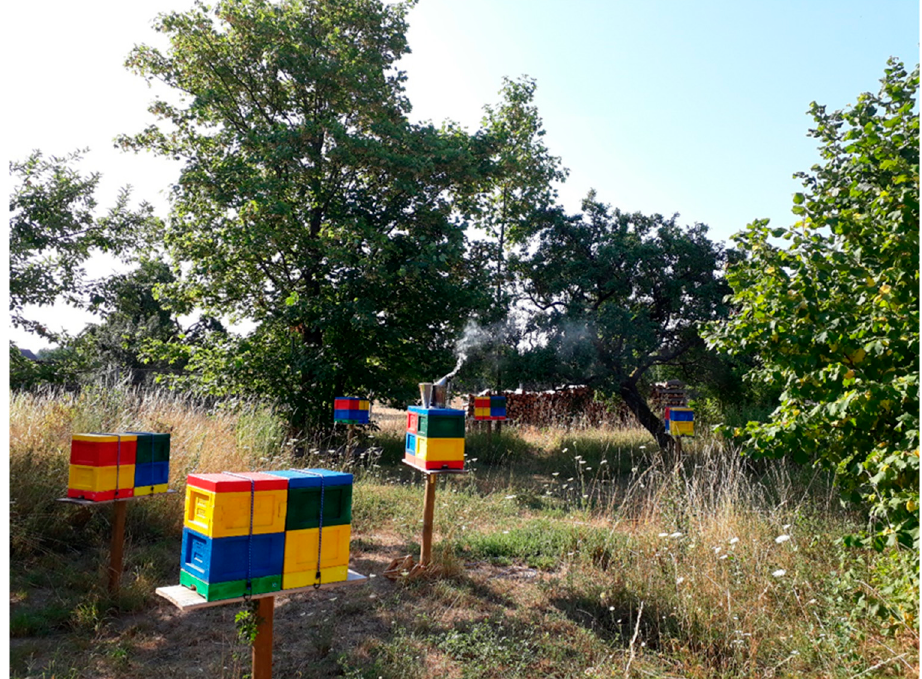
Figure 2. Location of experimental hives in a common apiary with four colonies of five subspecies of the Western honeybee Apis mellifera located in Southern Germany.